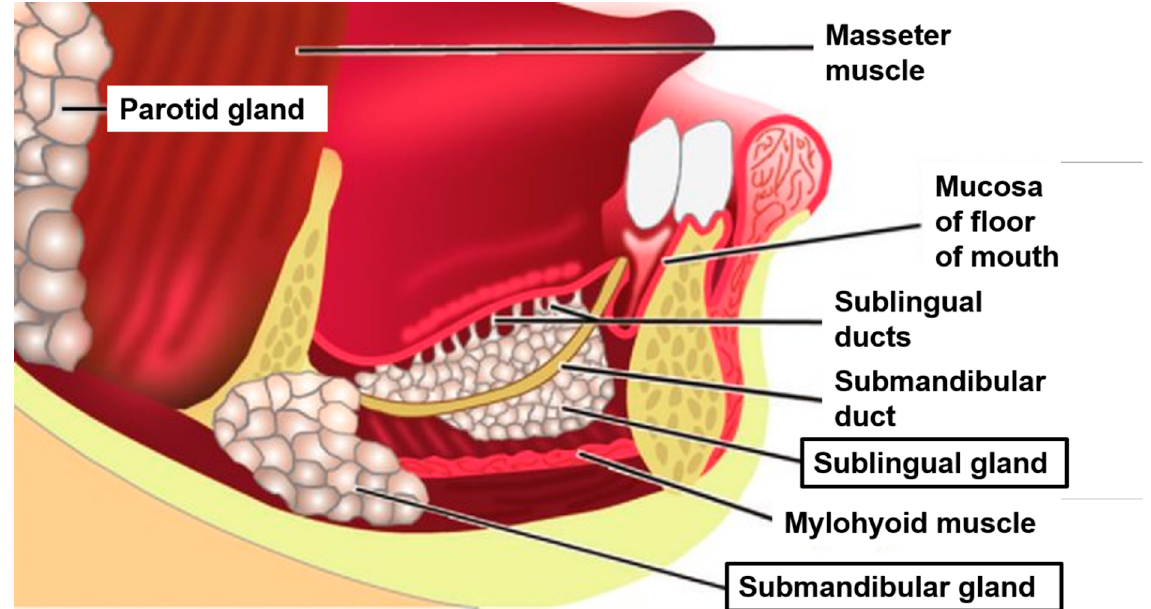
Figure 1. Drawing shows the location of the major salivary glands and its ducts. Note: Sublingual gland is located below the oral epithelium of the floor of the mouth. Adapted with permission of Radiological Society of North America, from “Imaging the Floor of the Mouth and the Sublingual Space”, 31, 5, 2011 [23]; permission conveyed through Copyright Clearance Center, Inc.